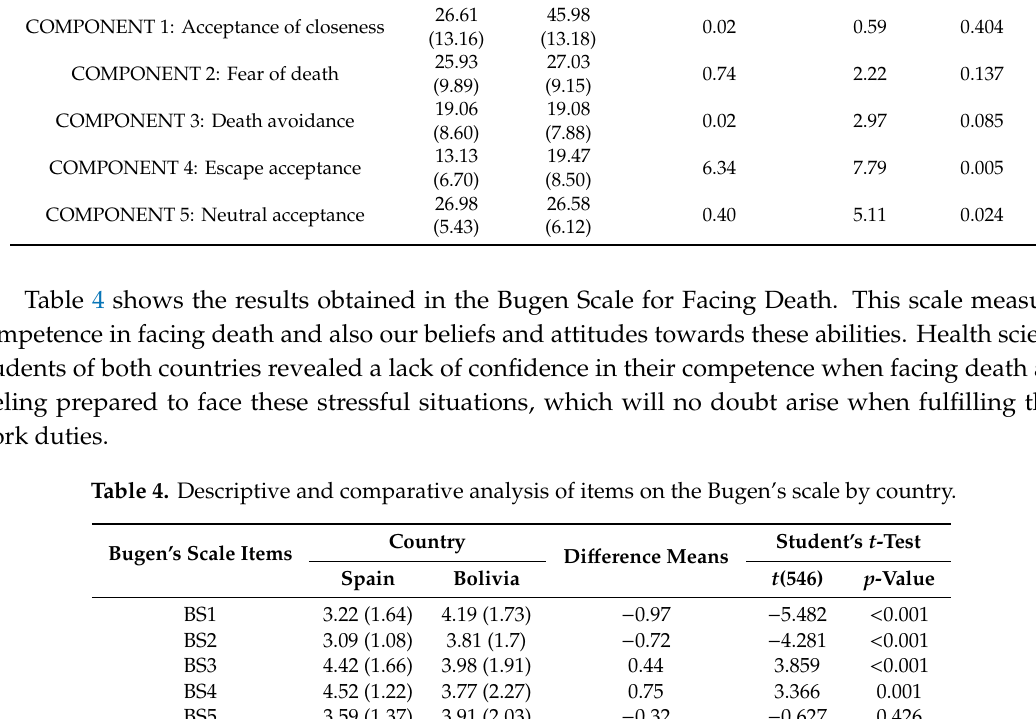
Table 3. Descriptive and comparative items of the PAM-R scale, by country. PAM-R Items